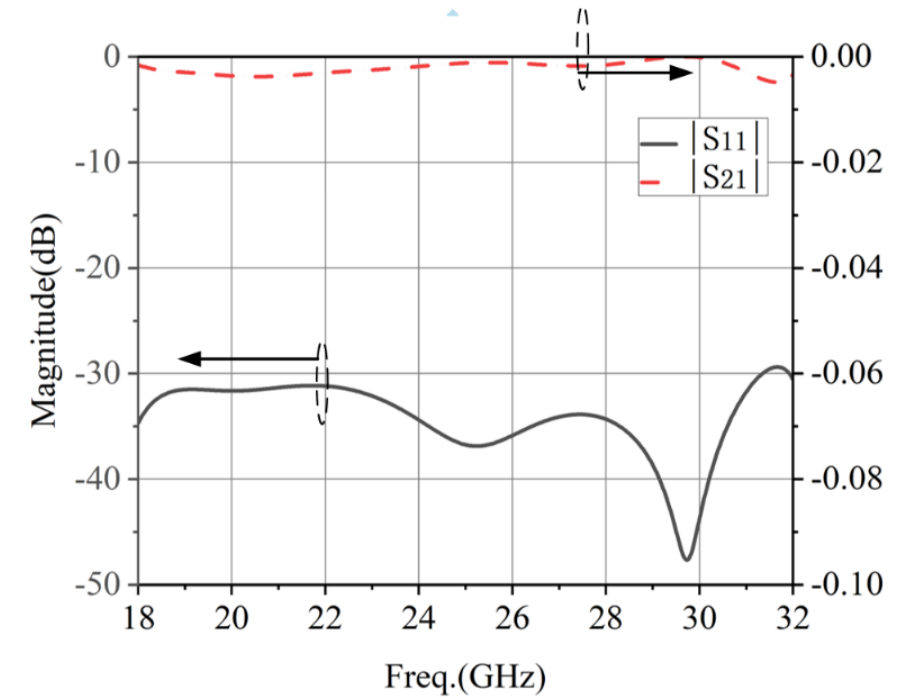
Figure 10. The simulated results of the four-level metal stepped waveguide converter.